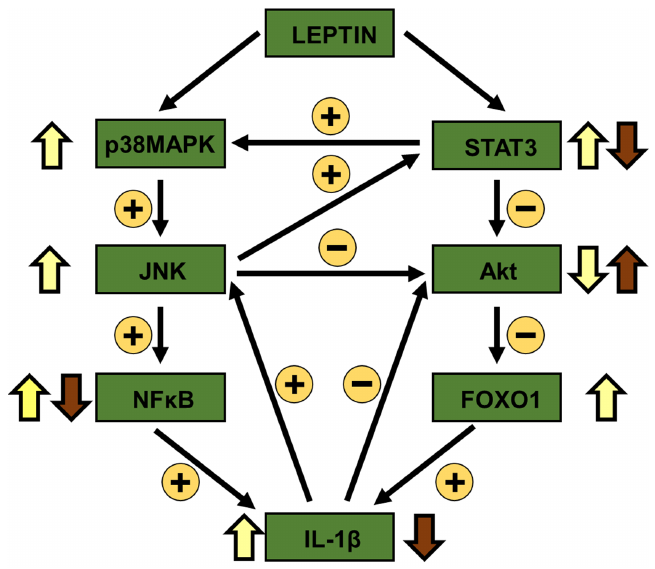
Figure 6. Proposed mechanism of action. Treatment with leptin increases inflammatory pathways in inguinal fat, stimulating proinflammatory cytokines, as IL-1 β . In addition, the augment in the activation of STAT3 in this fat depot may increase phosphorylation of p38MAPK and reduce Akt-related signaling, increasing FOXO1 levels that also promote an inflammatory environment. Proinflammatory cytokines activate inflammatory targets and inhibit Akt-related signaling. On the other hand, the reduction in leptin-related signaling in the liver may favor the increase in Akt activation that inhibits FOXO1. This fact could promote an anti-inflammatory environment in the liver of leptin-treated rats. Activation (or increase) and inhibition (or reduction) in inguinal fat (yellow arrows) or liver (brown arrows) is indicated. Akt, protein kinase B; FOXO1, forkhead box O1; JNK, c-Jun N-terminal kinase; IL, interleukin; NF κ B, nuclear factor kappa B; p38MAPK, p38 mitogen-activated protein kinase; STAT3, signal transducer and activator of transcription 3.